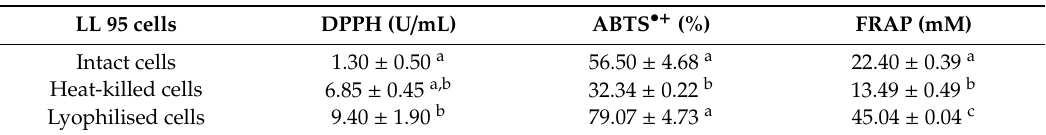
Table 5. In vitro antioxidant activities of Lactococcus lactis subsp. cremoris LL 95 on DPPH, ABTS • + and FRAP